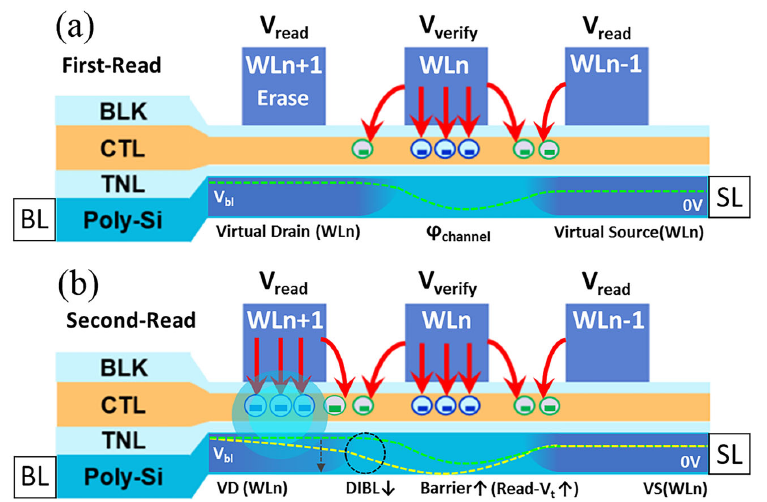
Figure 5. Schematic diagram of channel surface potential distribution near TNL side, when reading for ( a ) the first time and ( b ) the second time. The dashed line describes the distribution change of channel surface potential along the SL to BL